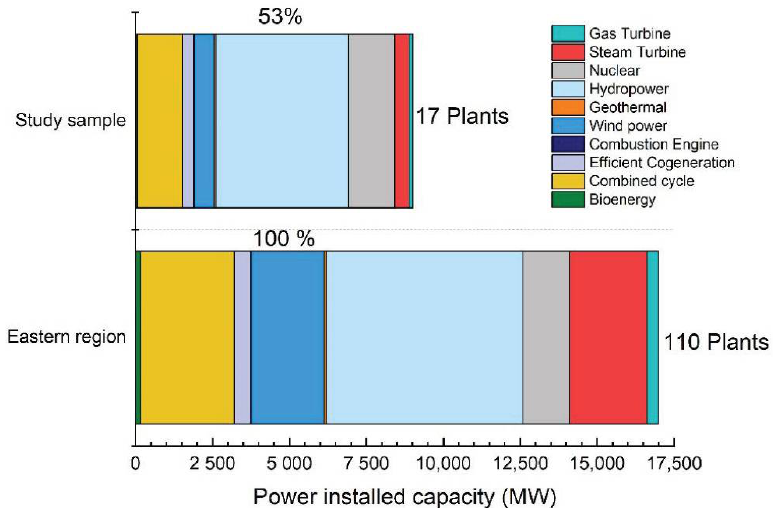
Figure 11. Power installed capacity by generation technology in the eastern zone of Mexico, and its relation to the study sample of 17 power generation plants, equivalent to 53% of the 110 plants installed capacity in the zone.